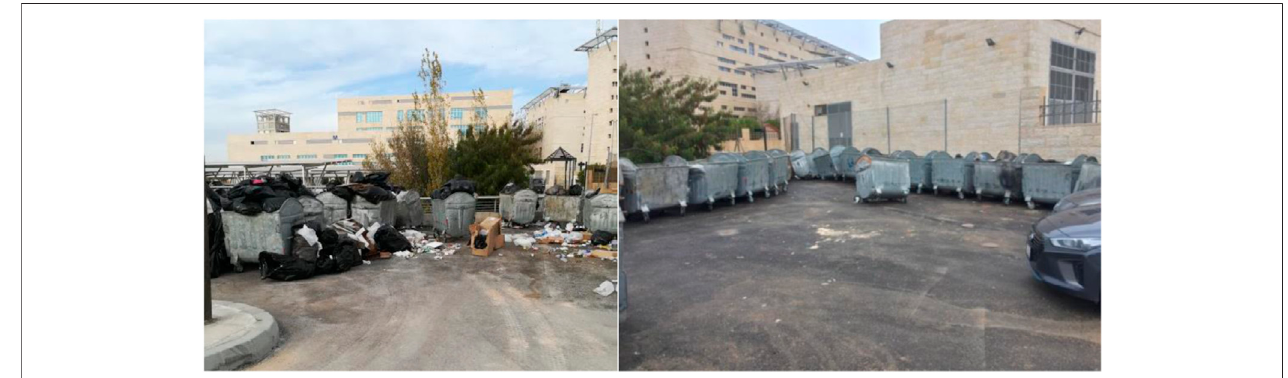
FIGURE 2 | Waste accumulation point at